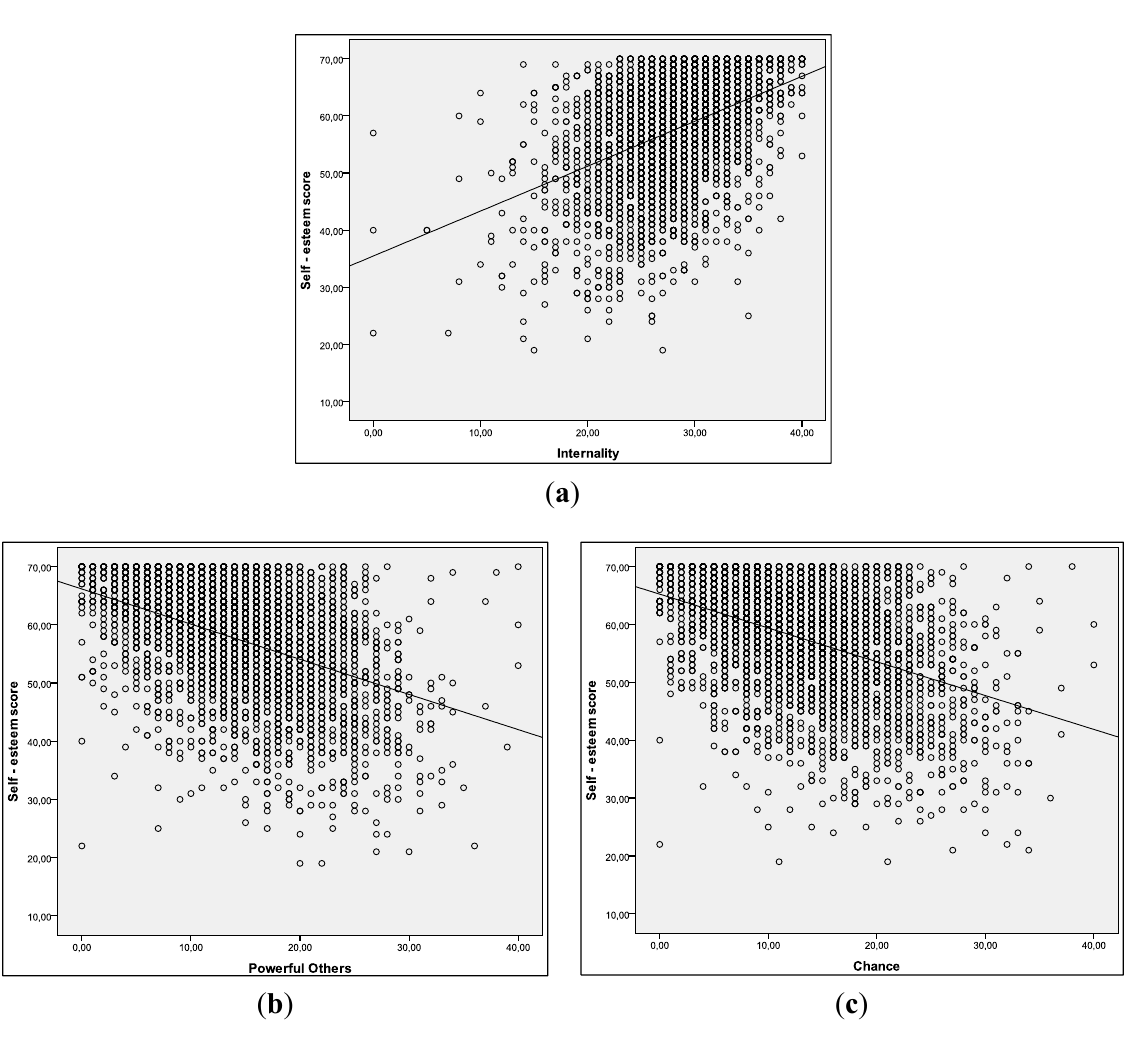
Figure 1. ( a ) Correlation between self-esteem and Internality; ( b ) Correlation between self-esteem and Powerful Others; ( c ) Correlation between self-esteem and